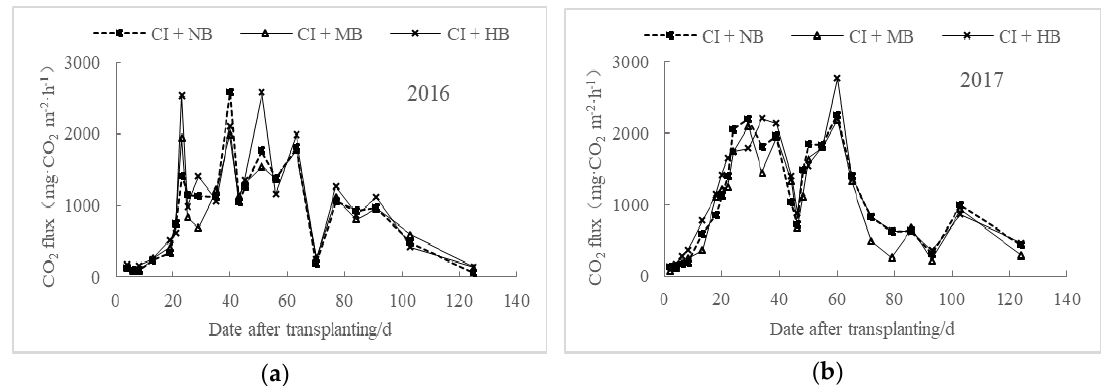
Figure 1. Dynamic changes of CO 2 emissions from water-saving rice paddies under different biochar application rates in 2016 ( a ) and 2017 ( b ).